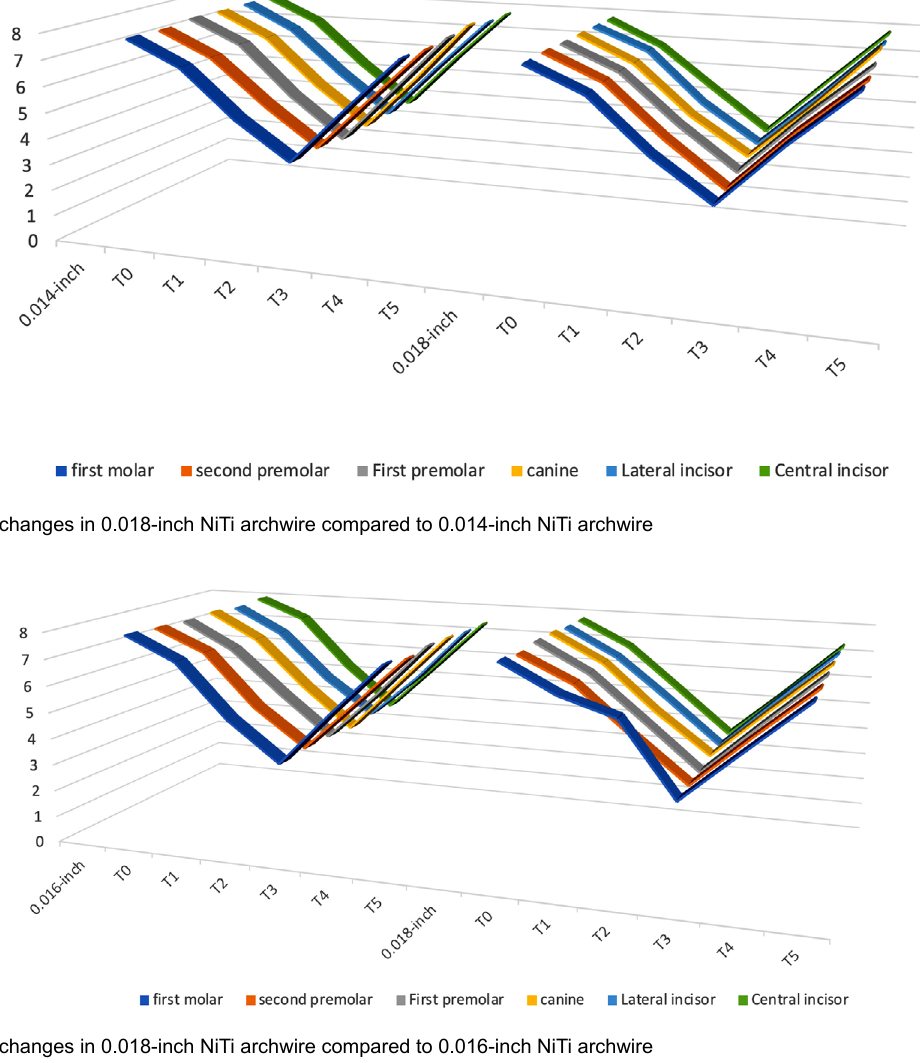
Figure 4- PBF changes in 0.018-inch NiTi archwire compared to 0.016-inch NiTi